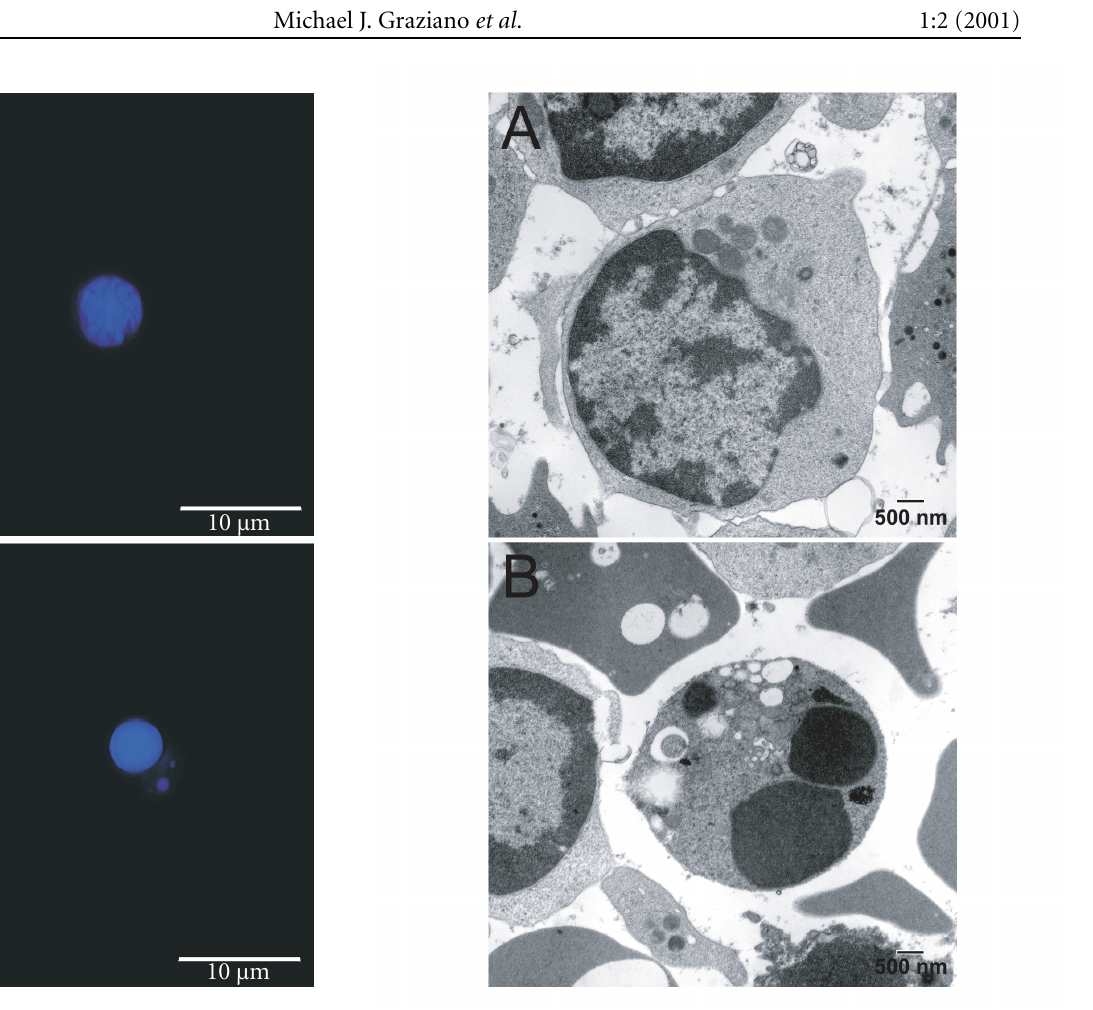
parison, less than 15% of lymphocytes treated with 30 µ